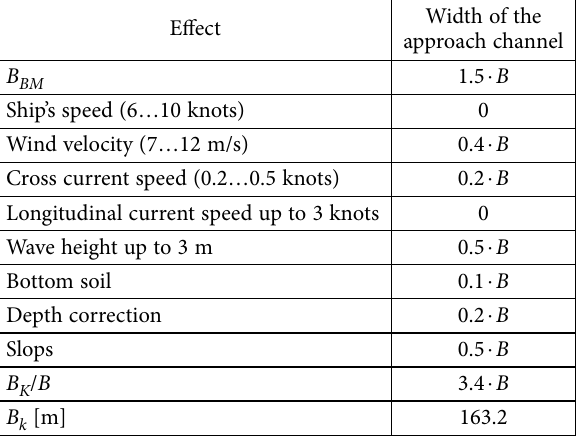
Figure 8. The width of the approach channel to the port for SUEZMAX ( L = 290 m), POST PANAMAX ( L = 250 m) and PANAMAX ( L = 220 m) ships was obtained by: 1 – calculation, 2 – PIANC (2014) recommendations, 3 – simulations, 4 – experiments on real ships methods for limit conditions (wind of up to 14 m/s in the perpendicular direction, waves were up to 2.5 Table. The width of the approach channel for the SUEZMAX tanker ( B = 48 m) according to PIANC (2014) recommendations